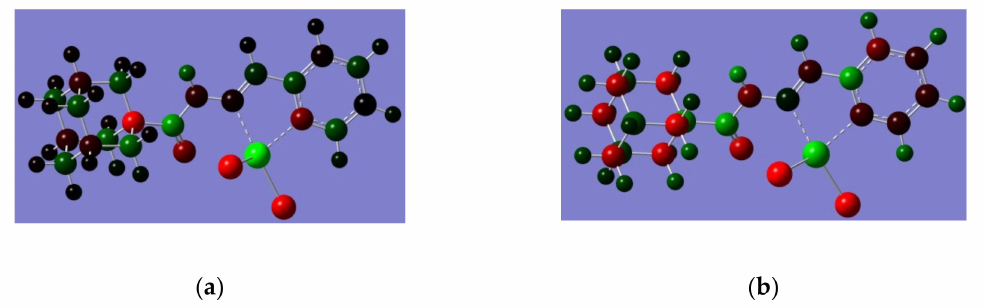
Figure 1. Electrostatic potential (ESP) for complex 1a ( a ) and 1b ( b ), where red presents the Mulliken negative charge distribution and green represents the positive charge